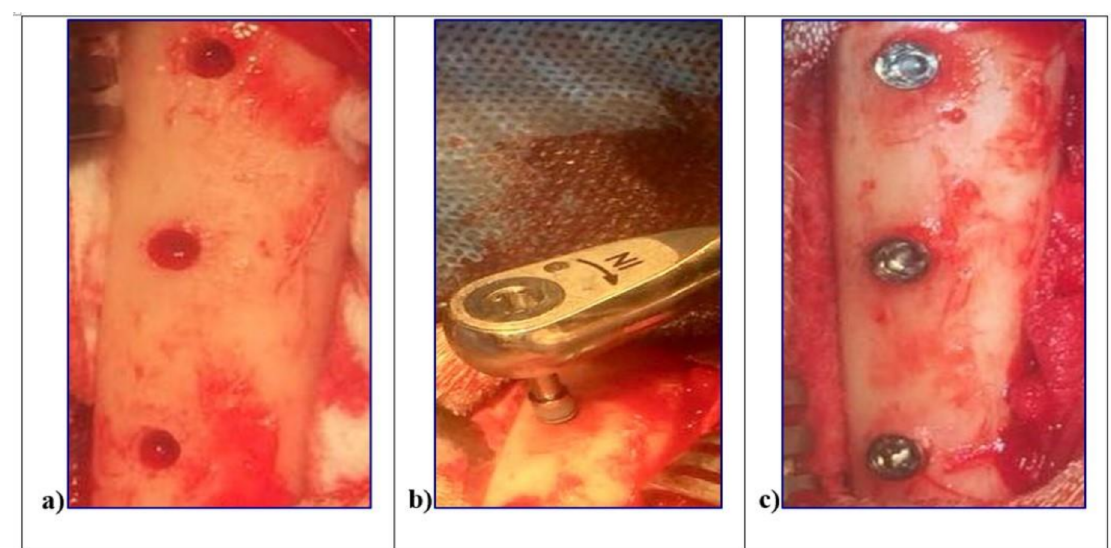
Figure 1. In vivo surgical procedures of the L1, L2, and sandblasted and acid etched (SBAE) implants insertion in sheep tibiae. ( a ) Surgical sites preparation. ( b ) Implant fixture insertion at 8.5 mm depth from the outer contour of the tibia. ( c ) Simultaneously, implants insertion to the top of the cortical bony